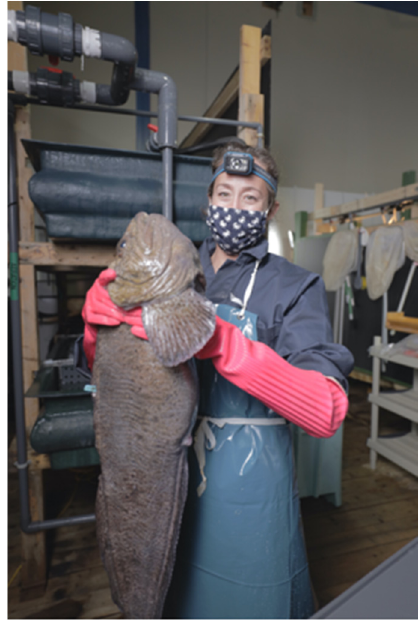
Figure 2. Broodstock fish in preparation for examination (blood sampling, semen or egg extraction or measurements) at MERINOV facilities (Grande-Rivière, QC. Canada). Source: MERINOV, Dupont-Cyr, B.-A.